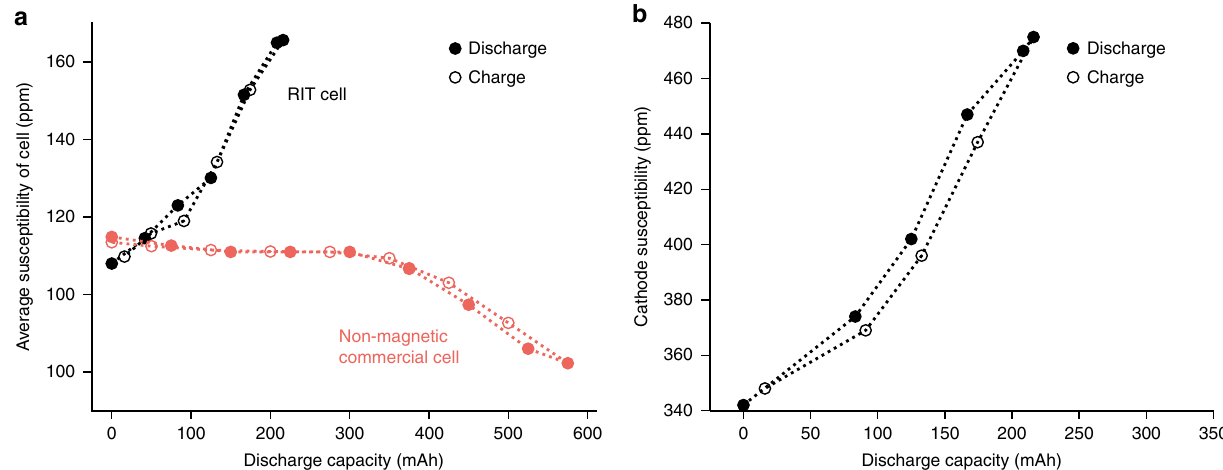
Fig. 3 Fitted magnetic susceptibilities of the cell during the discharge/charge. For simplicity, the cell is assumed to have a uniform volume susceptibility in a . Error bars are smaller than the size of the points. Knowing the cell construction, one can, however, also determine the average susceptibility of the cathode material in b . Details of the calculations are shown in Supplementary Table 1, Supplementary Table 2, and the Methods section. The susceptibility values are given in ppm indicating a factor of 10 –